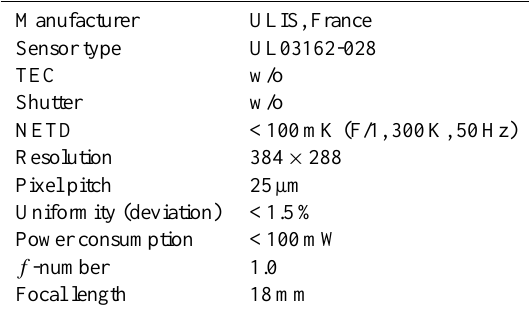
Table 1. Properties of the used infrared